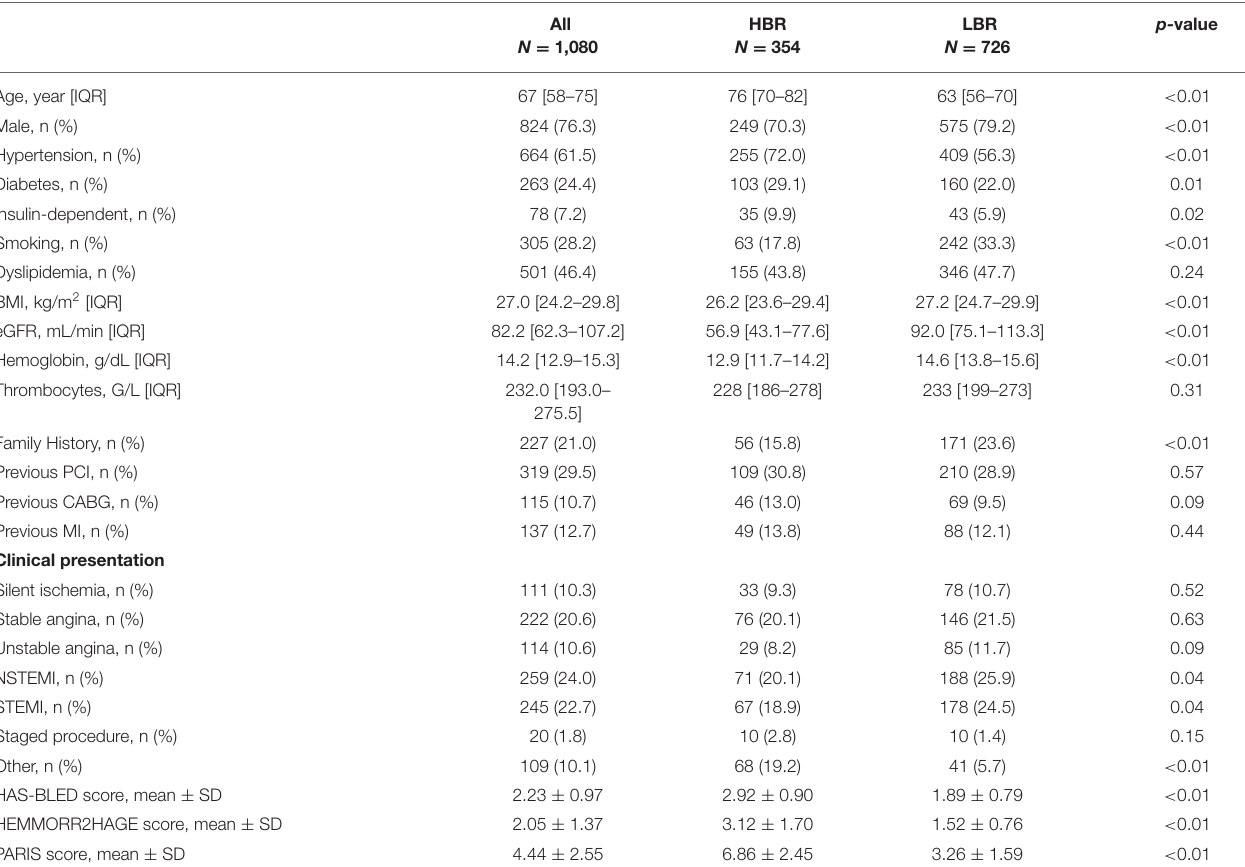
TABLE 2 | Baseline characteristics.